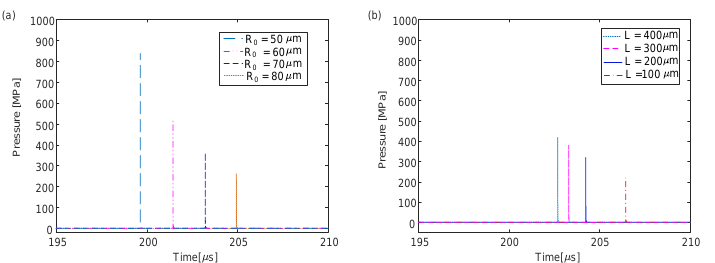
As the initial radius rises, the shock pressure decreases and the timing of pressure pulse delays. With the rise of initial radius, the amplitude of shock pressure descends more slowly. As to standoff distance, the trend is contrary to initial radius as shown in Figure 8b. The shock pressure generally increases with standoff distance. As distances increases, the maximum pressure changes more slowly and tends to be flat. The existence of wall acts as an obstacle for spherical explosion for bubble. The timing of pressure pulse decreases with the rise of standoff distance. The changing rate of pressure pulse timing is slower with the increase of distance L.